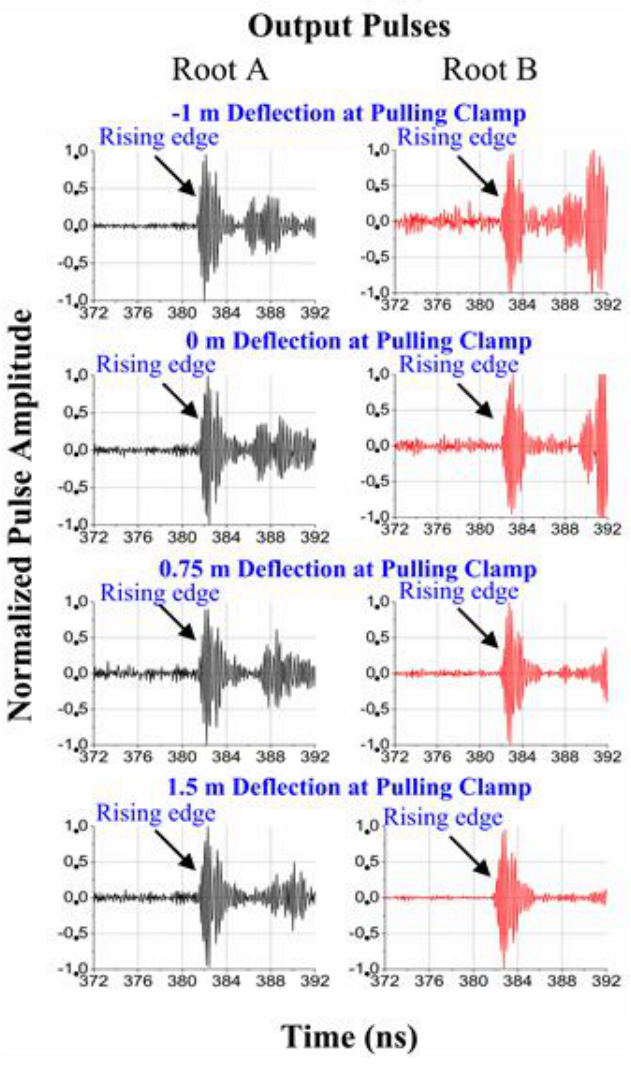
Figure 6. Normalized output pulse waveforms received by the root antenna A and the root antenna B. The peak voltages (or amplitudes) of the output first pulses are given under different deflections in Figure 7, which is normalized by the input pulse peak voltage. As the deflection changes, the peak voltages vary less than 6 dB and 15 dB for the root antenna A and the root antenna B, respectively. The lowest peak voltage of the root A occurs in the most important deflection range from 0 m to 1.5 m. However, with the selected height of the root antenna A off the blade root surface, the lowest peak voltage of the root antenna A is only 6 dB smaller than its highest value at −1 m